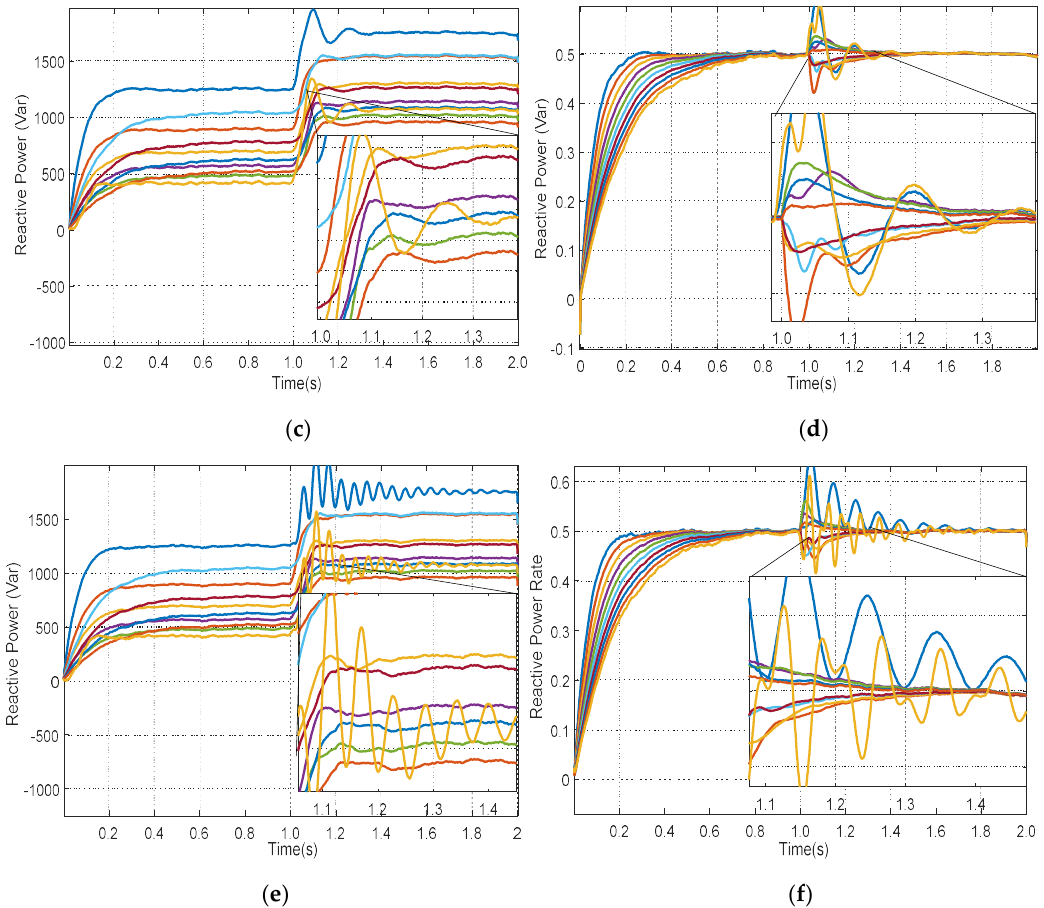
Figure 11. Simulation results for reactive power output of 10 DGs with time delays: ( a , b ) for time delay τ = 30 ms ; ( c , d ) for time delay τ = 55 ms ; ( e , f ) for time delay τ = 80 ms .